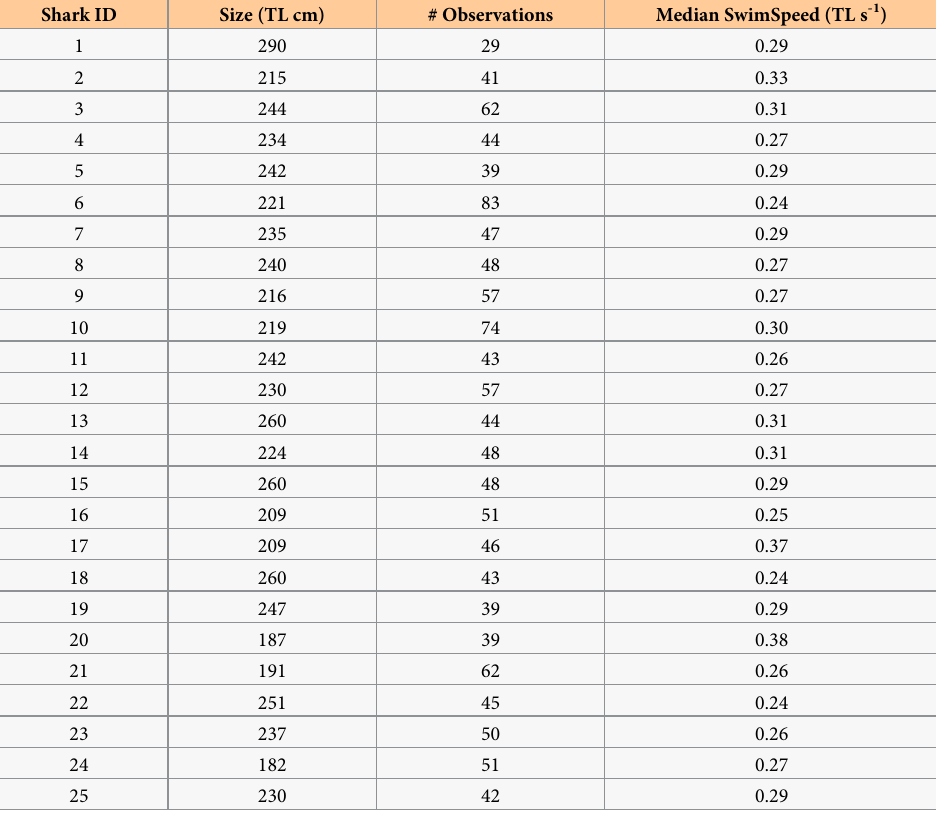
(depth), and therefore more accurate estimates of distance between derived locations, SS culations remain valid. Median SS across all animals included was 0.6 m s -1 (0.58 ± 0.001), slightly higher than T SS . Individual median SS ’s ranged from 0.6 m s -1 (0.54 ± 0.01) to 0.7 m s -1 (0.69 ± 0.01) H T (Table 1). Cruising speed calculations derived from unmanned aerial vehicle (UAV) tracking of 25 individual JWS swimming within the array, in a single day, were also marginally lower than those of calculated SS when standardized to body size. Median calculated velocity via H UAV was 0.6 m s -1 (0.66 ± 0.005). Corresponding median cruising speed, standardized to body size were 0.3 U TL s - 1 (0.29 ± 0.002), slightly lower than those derived via calculated SS (Table 2). Relationship of cruising swimming speed to biotic and abiotic variables Water temperature within the array was observed to be largely stratified by depth, with tem- peratures ranging from 12.5˚C to 22.4˚C (mode = 15.4˚C, mean = 18.1˚C ± 0.01˚C, median = 17.8˚C. Six percent of all rendered geopositions were associated with corresponding water temperatures of 15˚C or less, while 55% corresponded to temperatures between 15˚C and 18˚C. We compared calculated swim speeds against a range of biotic and abiotic variables. The nature of this telemetry data likely induced autocorrelation, and we employed tools that addressed this. Namely, we performed hypothesis tests using a block bootstrap approach that is robust to serial correlation. Table 3 contains a summary of our results. As mentioned above, Table 2. UAV derived JWS cruise speeds. Shark ID Size (TL cm) # Observations Median SwimSpeed (TL s -1